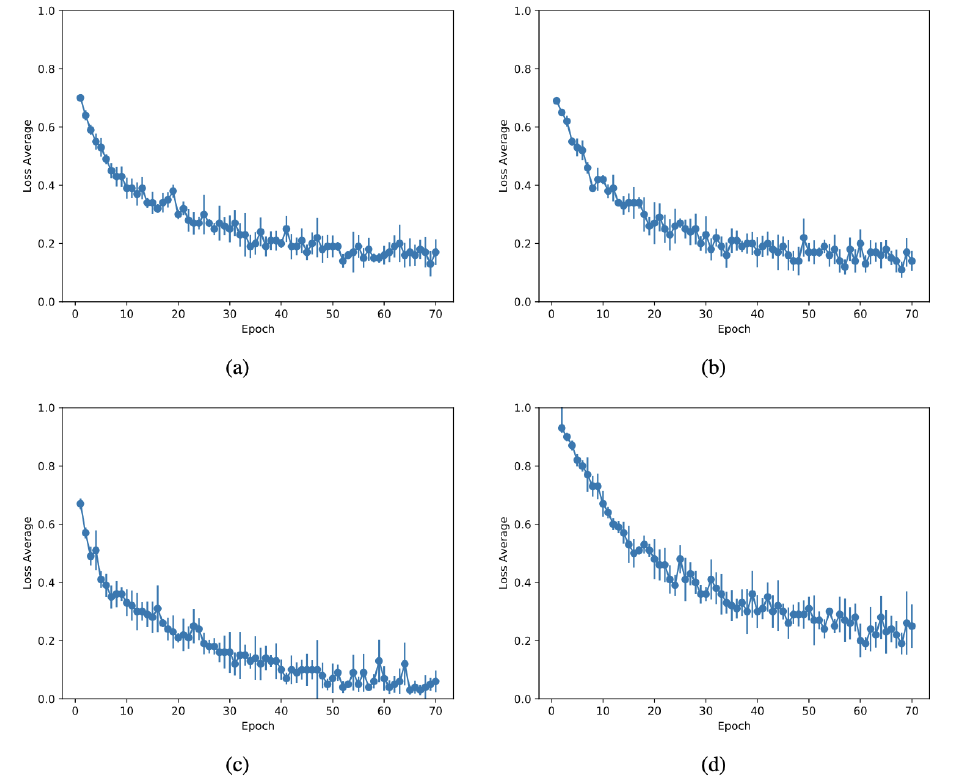
Figure 7. Loss curves with error bars depicting the loss for the epochs for the different architectures evaluated: DenseNet ( a ), ResNet ( b ), SqueezeNet ( c ), and InceptionV3 ( d